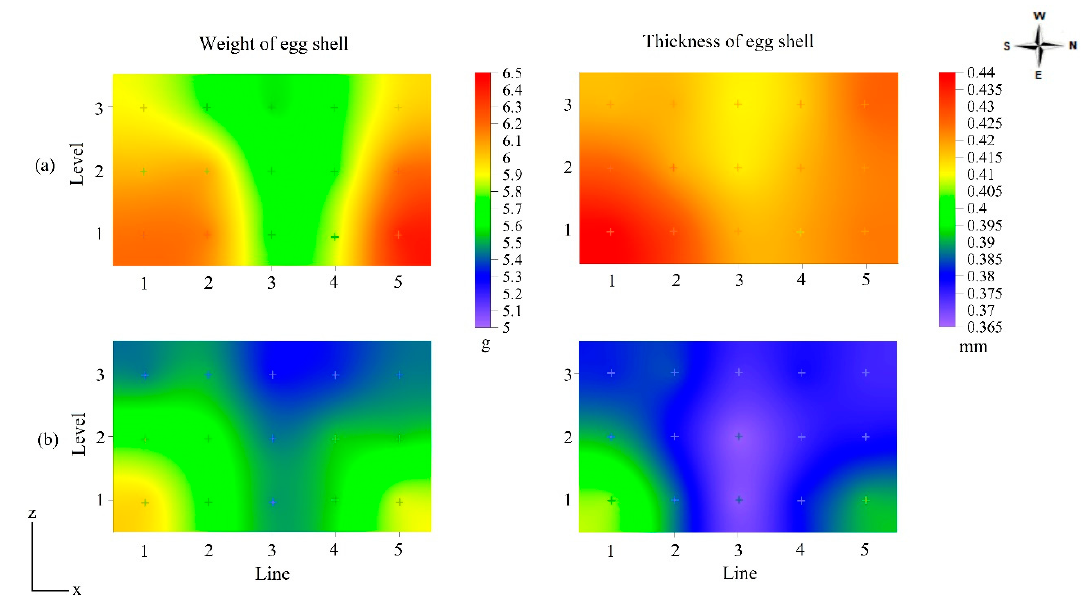
Figure 6. Spatial distribution, in cross-section, of the mean values of shell weight (g) and thickness (mm) in five aviaries obtained in winter ( a ) and summer ( b ).